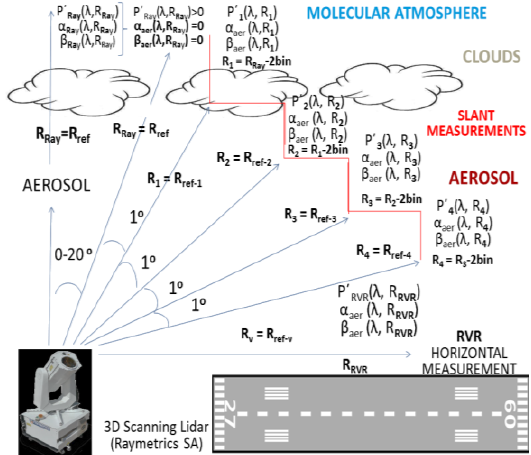
Fig. 1. The LADDER or 3D Stepping working principle